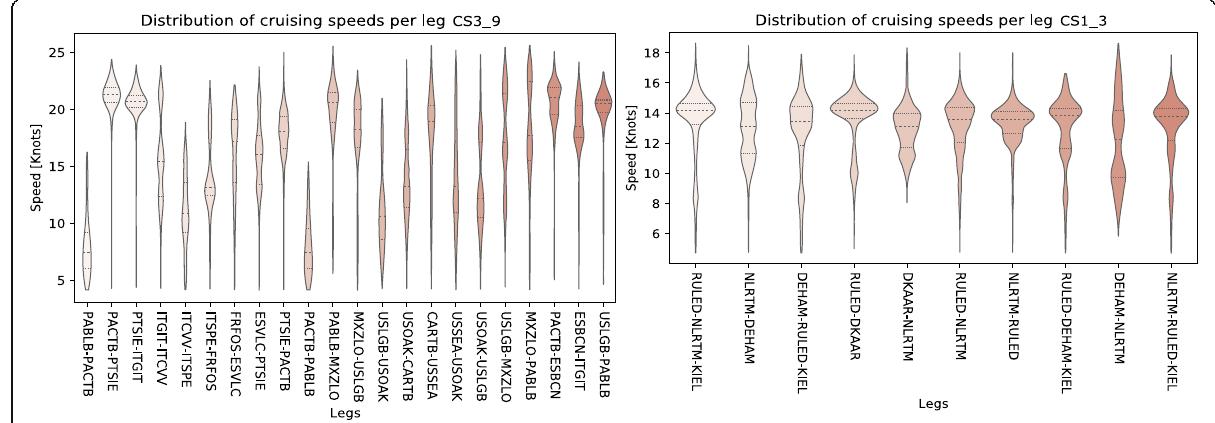
Fig. 5 Distribution of cruising speeds per leg for two ships of the same type but different segment, one with a very accused speed variation (CS3_9) and one with relatively low variation (CS1_1). The high dispersion observed is not a result of having very different legs in the itinerary. Even the same leg can present large variations of speed, as can be easily observed for both ships